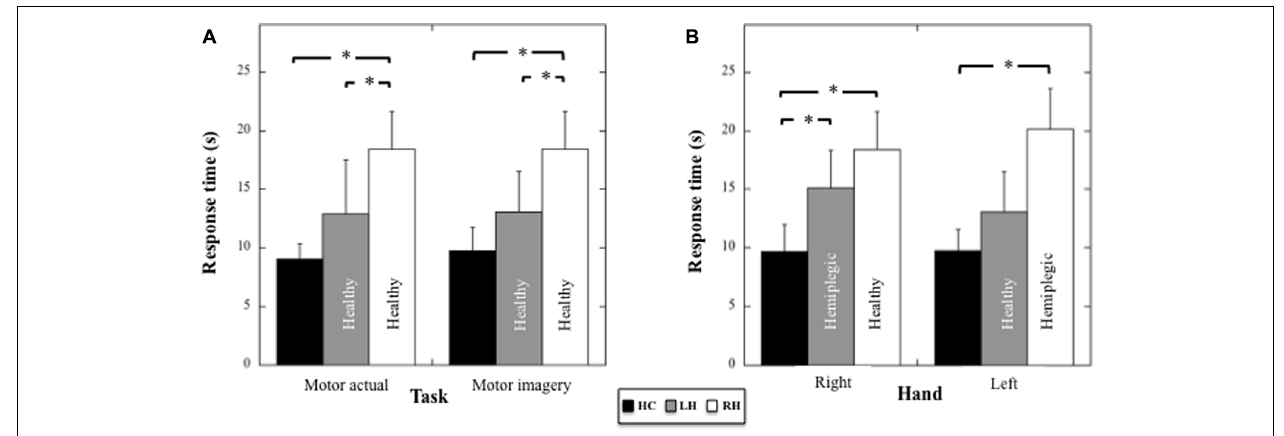
FIGURE 4 | (A) Mean response times (and SD, in seconds) for HC, LH, and RH in the motor actual and imagery tasks performed with the healthy hand. (B) Mean response times (and SD, in seconds) for HC, LH, and RH in the motor imagery tasks performed with the right or the left hand. Asterisk indicate significant statistical